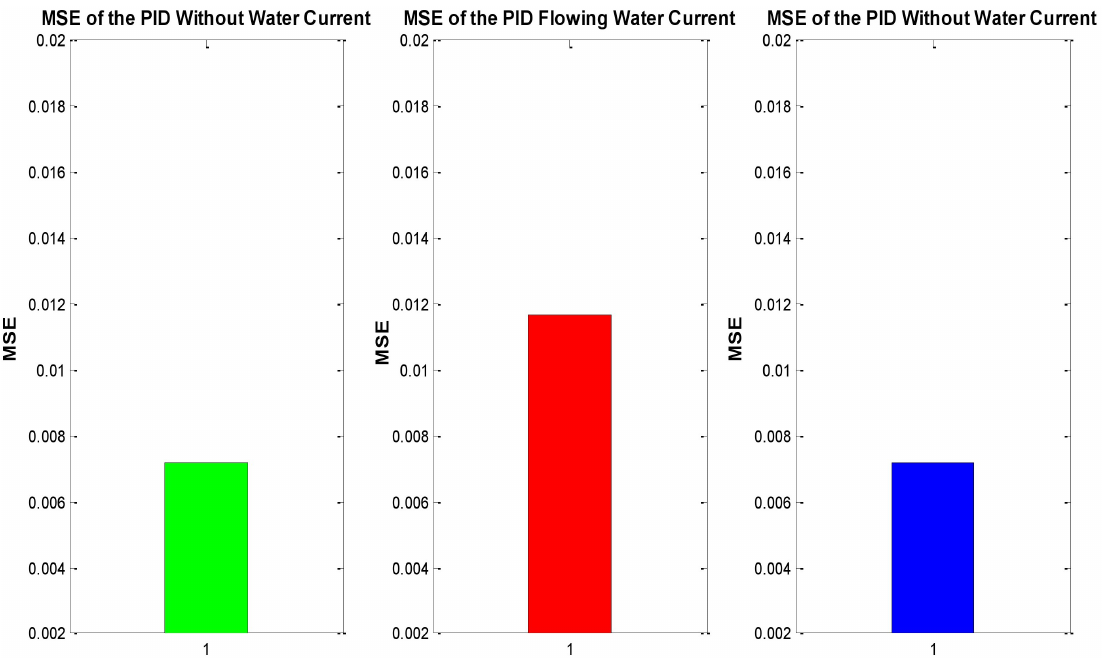
Figure 13. MSE of the conventional PID Controller position tracking